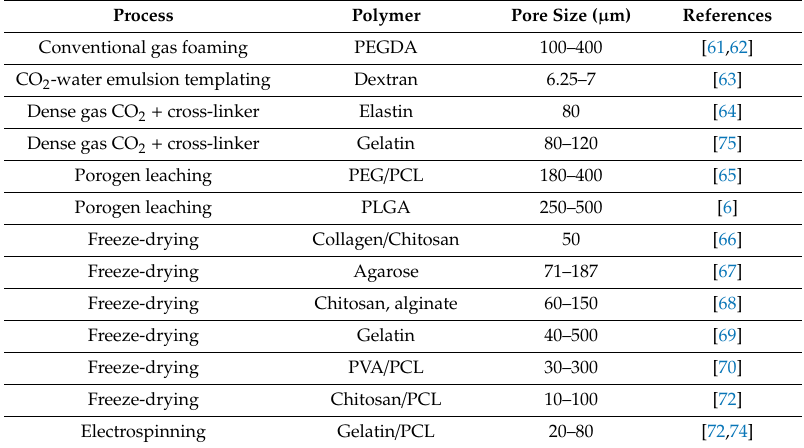
Table 3. Pore sizes generated using various processes for different scaffolds. Process Polymer Pore Size (µm) References